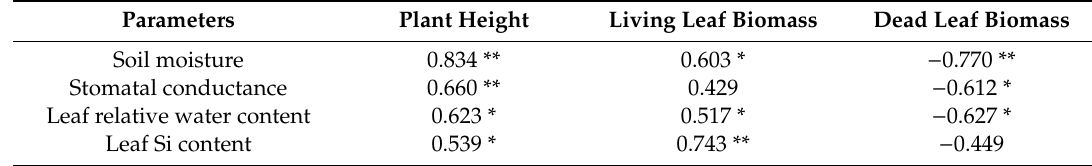
Table 6. Pearson correlations between specific parameters for the proso